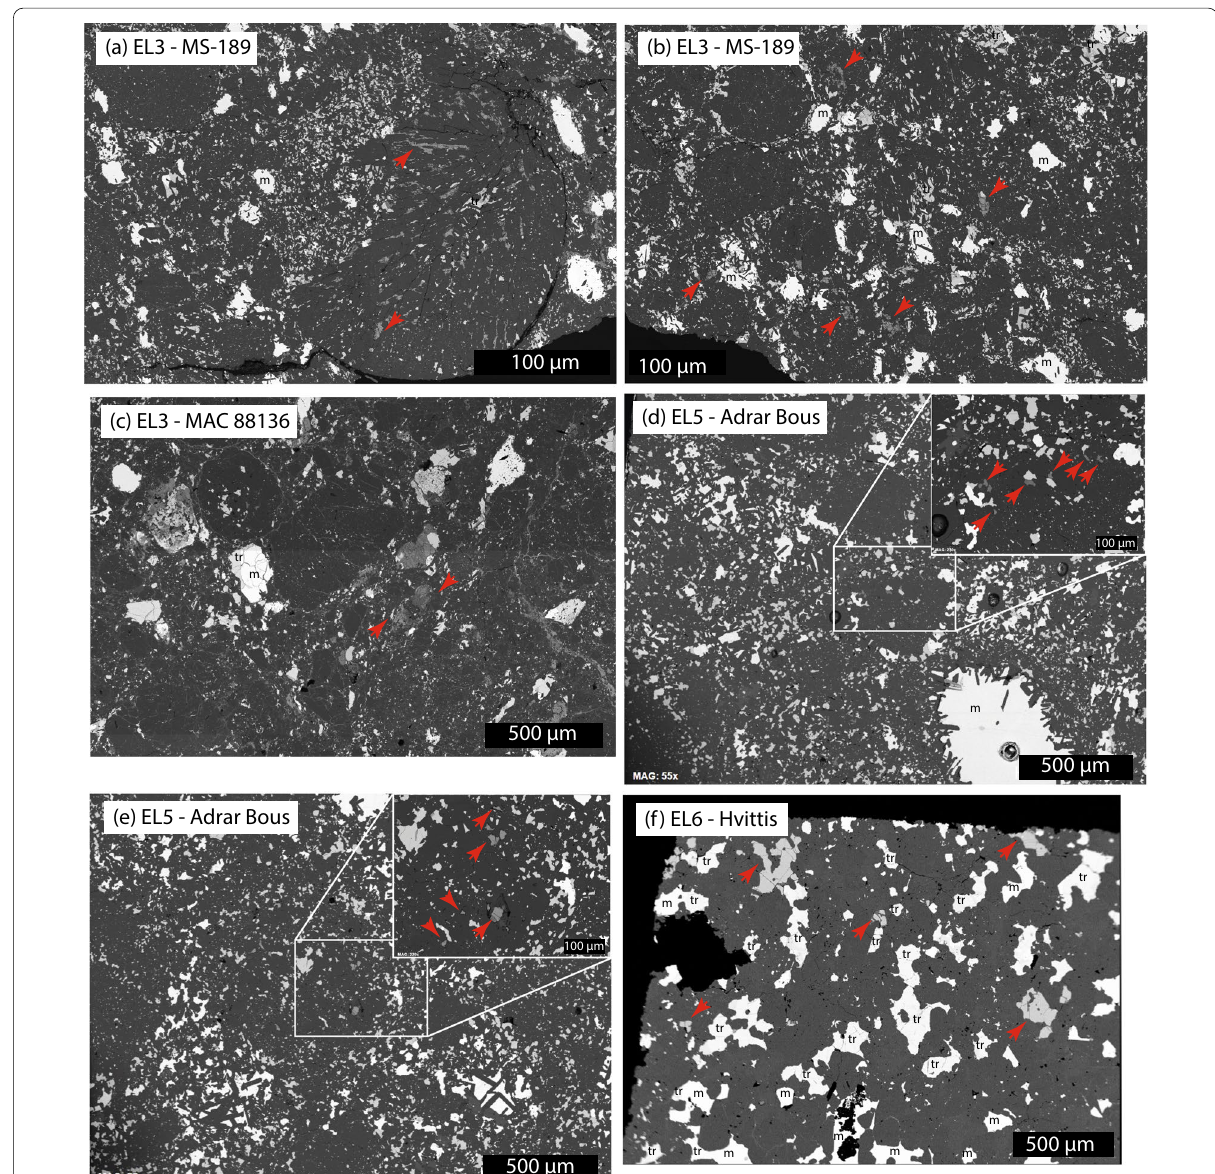
Fig. 3 Scanning electron images of some of the EL samples studied, illustrating the textural position of the oldhamite grains, indicated by the reds arrows. Also indicated are the metal (m) and troilite (tr)